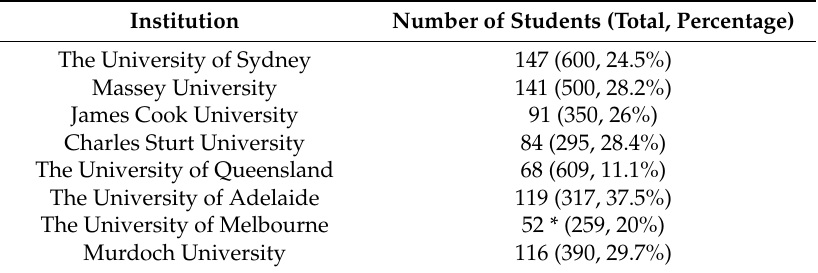
* Only first and second year students